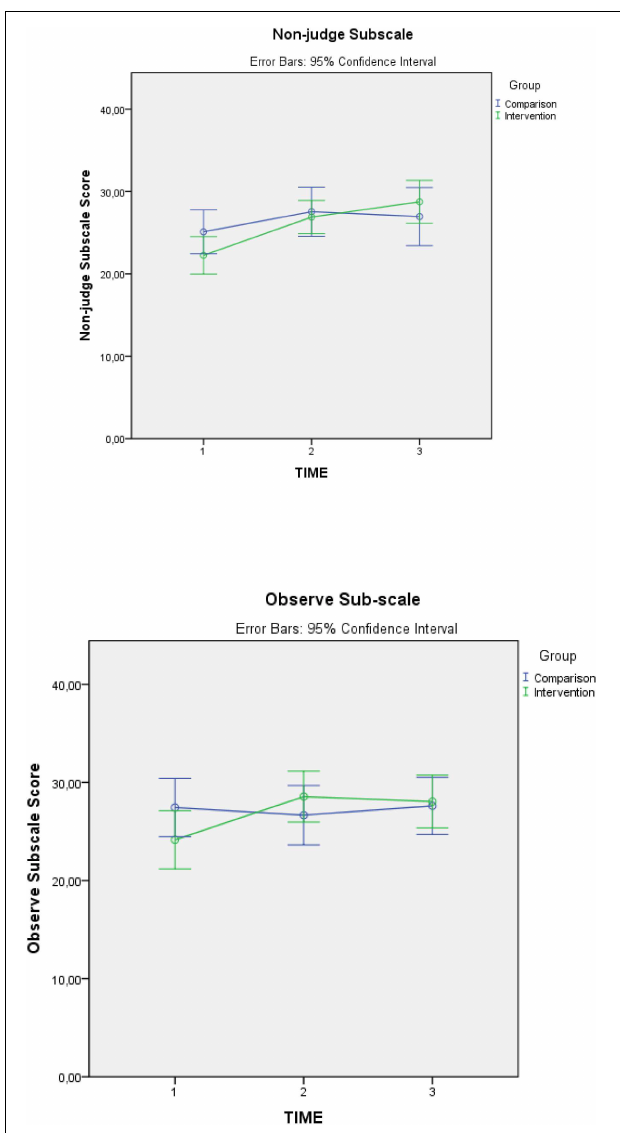
FIGURE 4 | FFMQ observe and non-judge subscales marginal pre, post, and follow-up